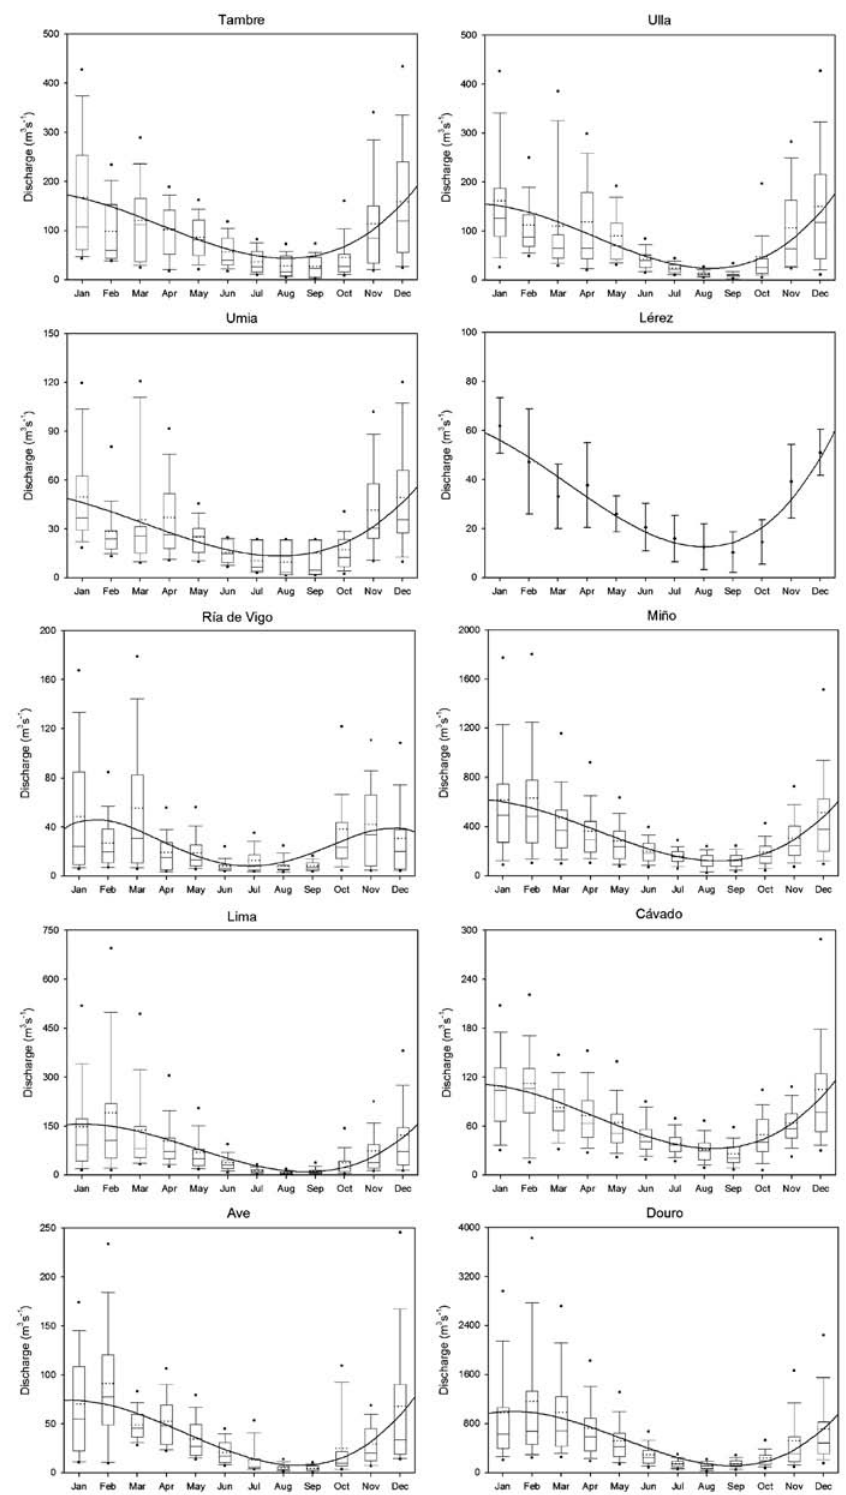
Fig . 3. – Main monthly statistics for the study rivers. The boundary of the box closest to zero indicates the 25 th percentile, the solid line within the box marks the median, and the boundary of the box farthest from zero indicates the 75 th percentile. Whiskers above and below the box indicate the 95th and 5th percentiles respectively. Dots indicate the minimum and maximum values. In addition, the mean is graphed as a dotted line. In the case of the River Lérez, statistics were computed directly from the few available monthly means and not from estimations of daily discharge data. In this case, only the mean and their associated error bars (±1 σ ) are plotted. Curves correspond to the polynomial adjustment from monthly means, with an imposed cyclic behavior